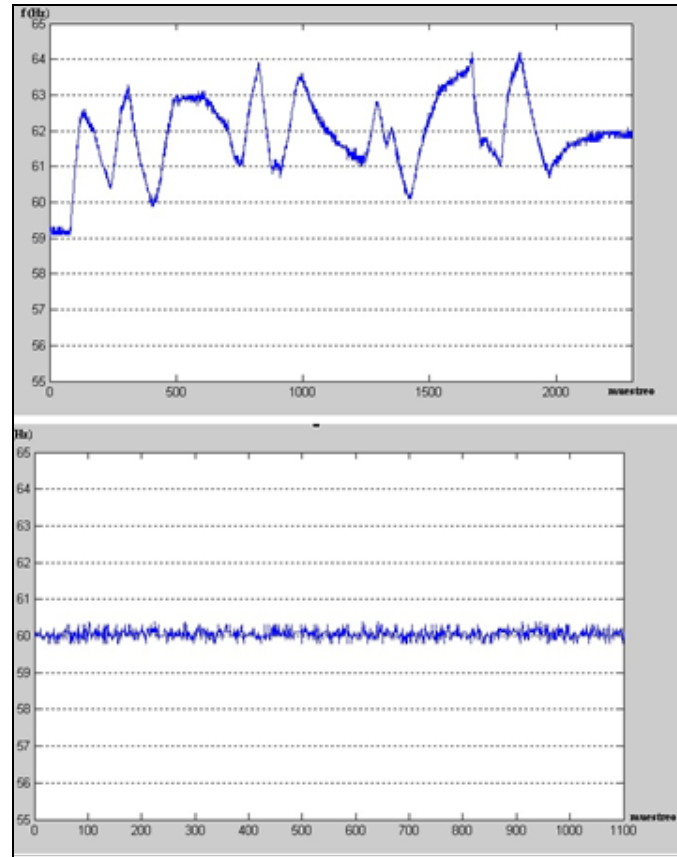
Figura 9: Resultado comparativo de pruebas experimentales para control local de la frecuencia en la mini-hidroeléctrica. Fuente: